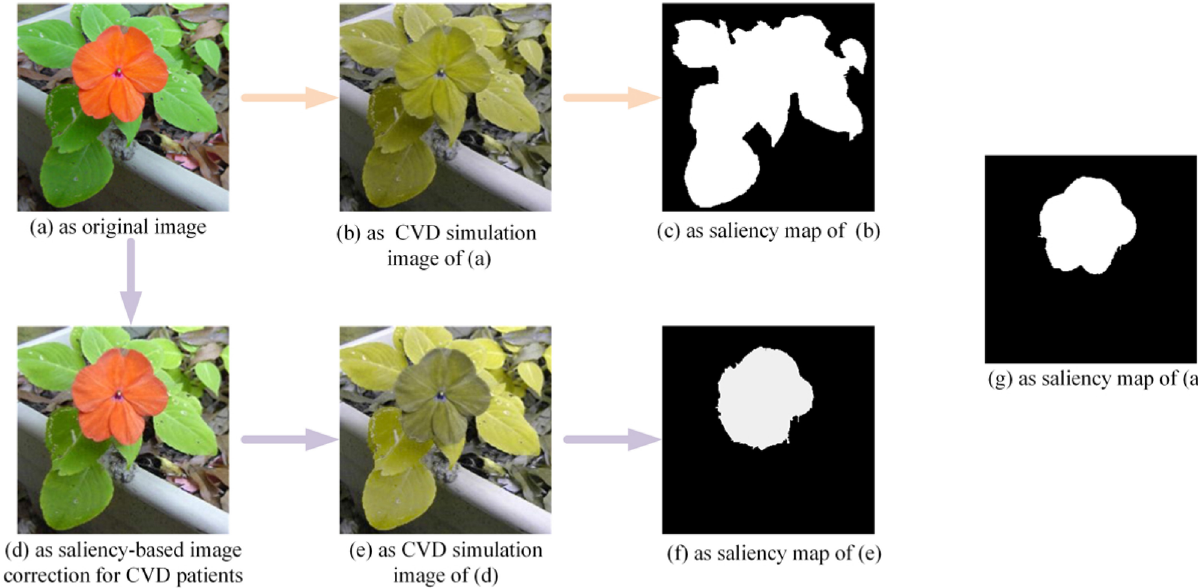
Fig. 1 Saliency detection results after CVD simulation, for a standard image (a, b, c), and a corrected image (d, e, f), compared to saliency with normal vision